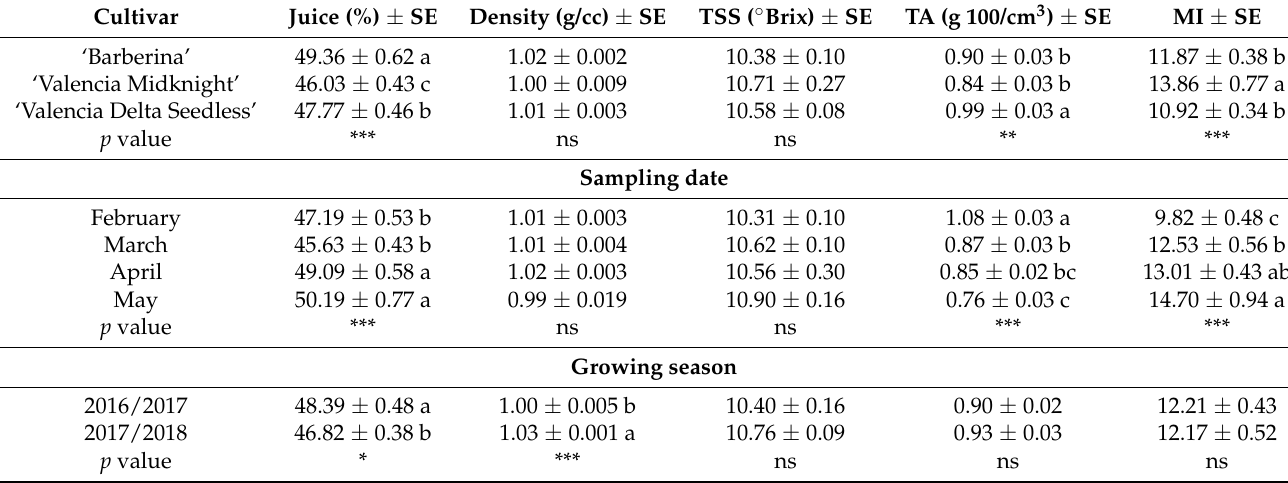
Table 2. Mean of orange fruit physicochemical parameters ± standard error (SE) of each cultivar (‘Barberina’, ‘Valencia Midknight’ and ‘Valencia Delta Seedless’), each sampling date (February, March, April, May) and each growing season (2016/2017 and 2017/2018) tested using the same rootstock (Forner-Alcaide no. 5).